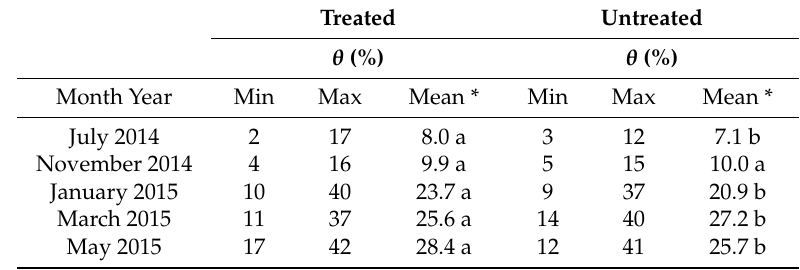
Table 1. Soil water content ( θ ) variability by sample month in the treated and untreated watersheds. Treated θ (%)